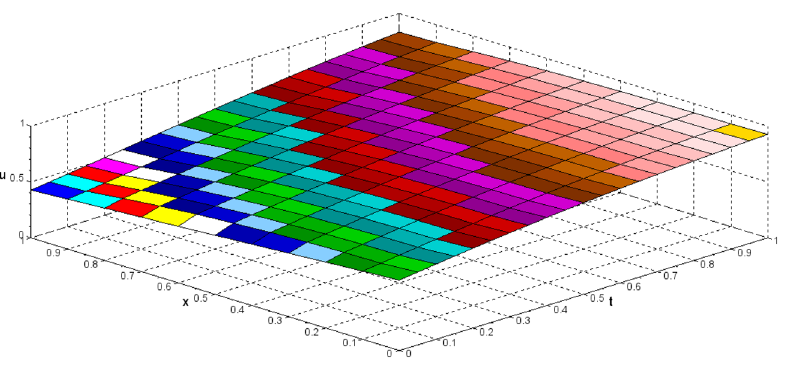
Fig. 2 I-EFD solution of Example 5.1 for (cid:2) t = 0 . 05 and (cid:2) x = 0 . 1 Table 4 Absolute errors of Example 5.2 of I-EFD, FI-EFD (for (cid:2) x = 0 . 0125, (cid:2) t = 10 − 4 ), and the methods of [24] x / t Method 0.2 0.4 0.6 0 . 2 UCBS